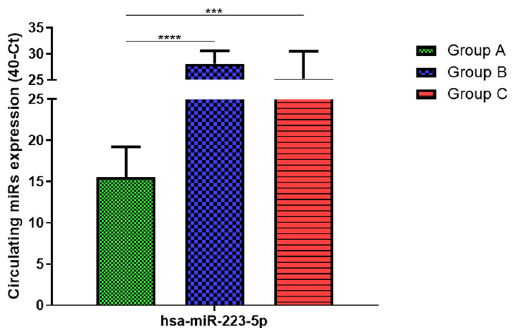
Figure 2. Serum levels of hsa-miR-223-5p in HNW (Group A), MANW (Group B) and HNAO (Group C). Results were shown as means ± SD. The statistical tests used in these analyses were one-way analysis of variance using Kruskal–Wallis test followed by Dunn’s Multiple Comparison Test. *** p < 0.001, **** p < 0.0001.